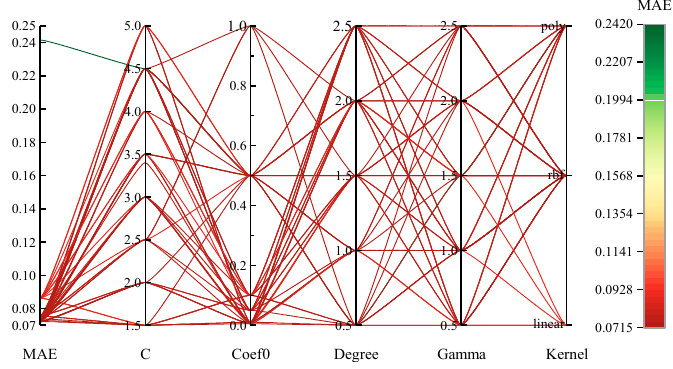
Figure 9. Process for optimizing SVM hyperparameters.